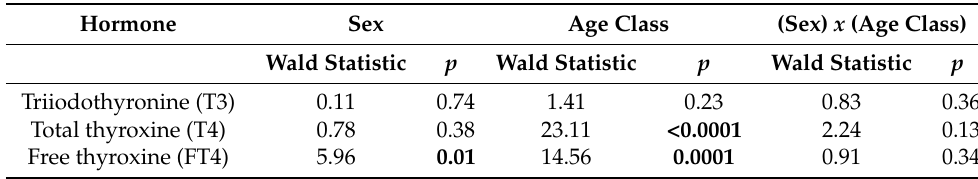
Table 4. Generalized linear model (GLM) results testing the association between hormone concentra- tions and demographic factors. Values in bold are significant at p <